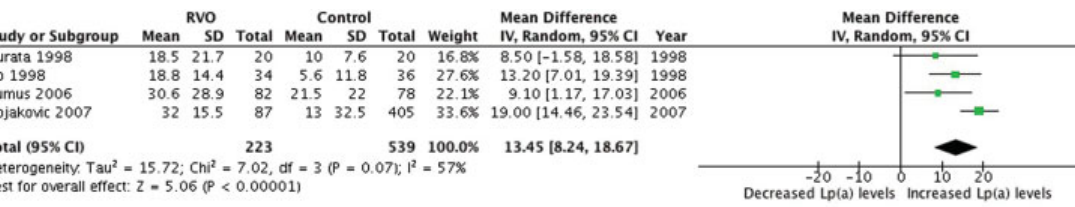
Fig. 4 Forest plot evaluating the WMD in Lp(a) levels between patients with RVO and controls. CI, con fi dence interval. Lp(a), lipoprotein (a); RVO, retinal vein occlusion; WMD, weighted mean